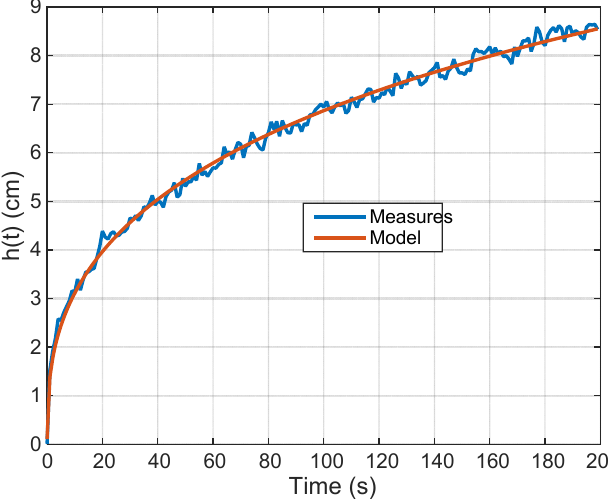
Figure 4. Comparison of the measures and the model response.